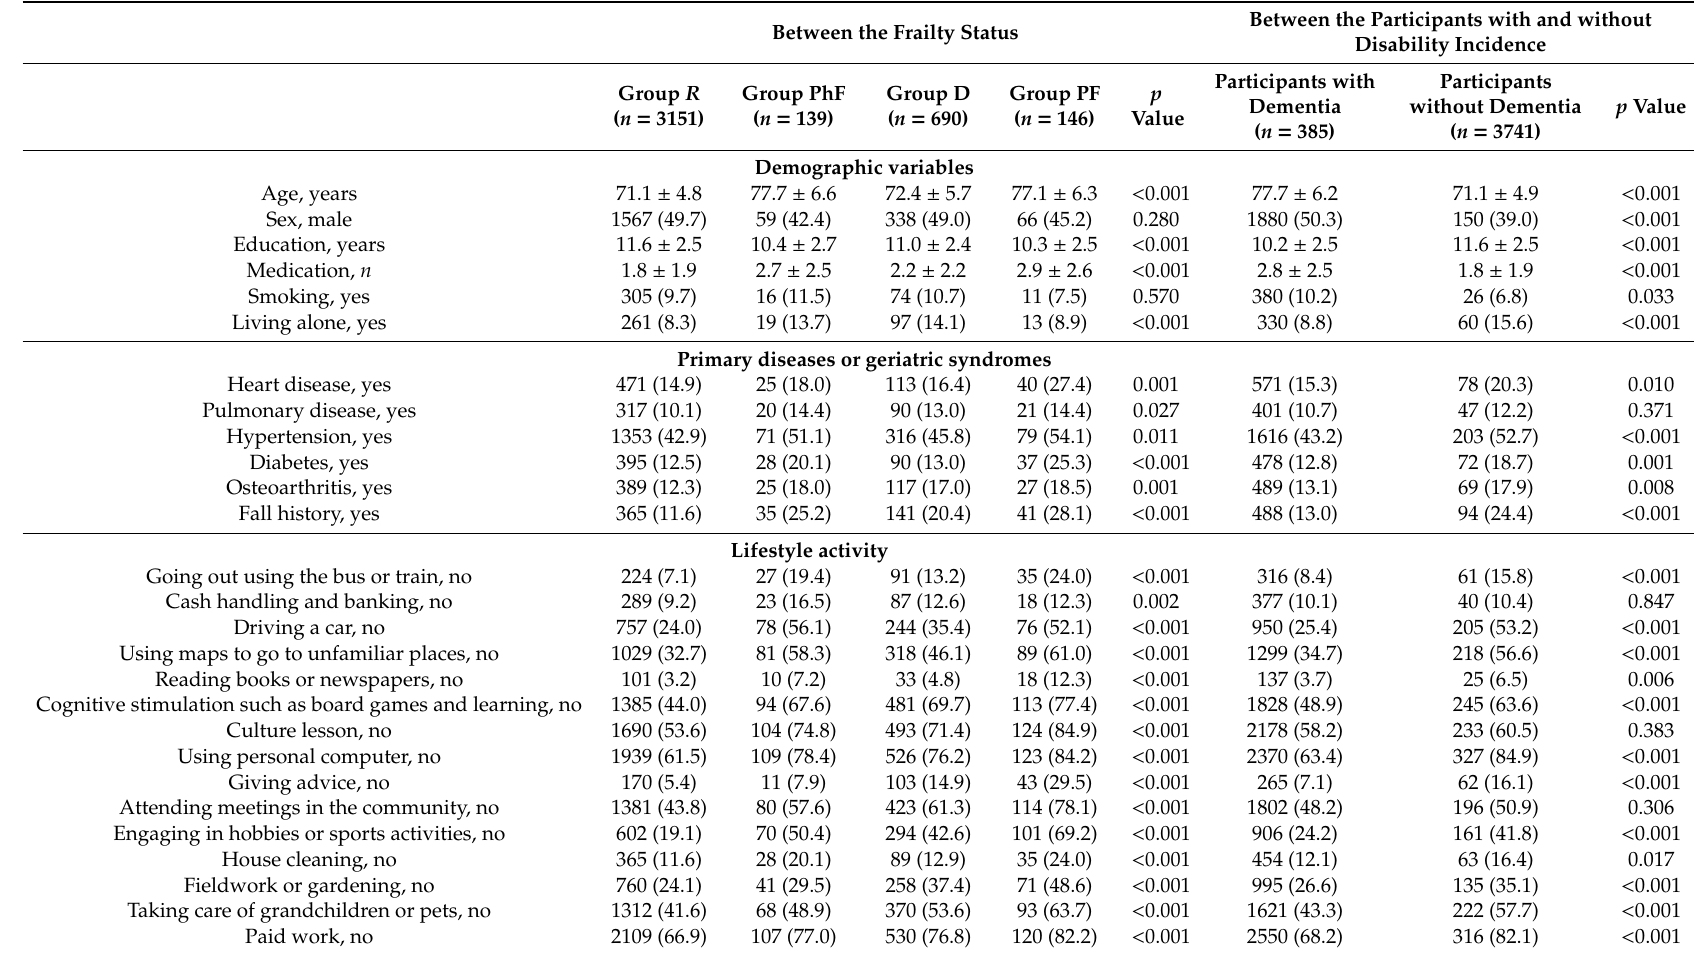
Table 1. Comparisons of baseline characteristics according to frailty status and between participants with and without